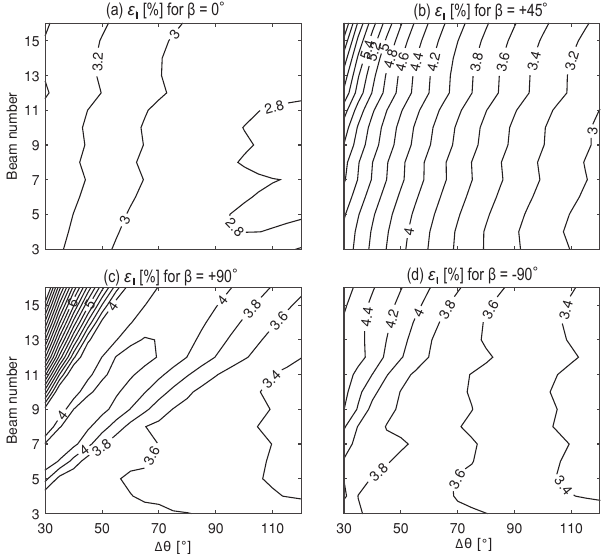
Figure 4. Dependence of relative standard error ( ε l ) of wind speed ( V 0 ) on arc span ( (cid:49)θ ) and beam number per arc scan for relative directions (a) β = 0 ◦ , (b) β = + 45 ◦ , (c) β = + 90 ◦ , and (d) β = − 90 ◦ with φ = 16 . 7 ◦ and r = 313m. The results are calculated for V 0 = 7ms − 1 and TI = 12% over a 10min period. The Coriolis pa- rameter f 0 = 0 . 0001s − 1 . The contour interval is